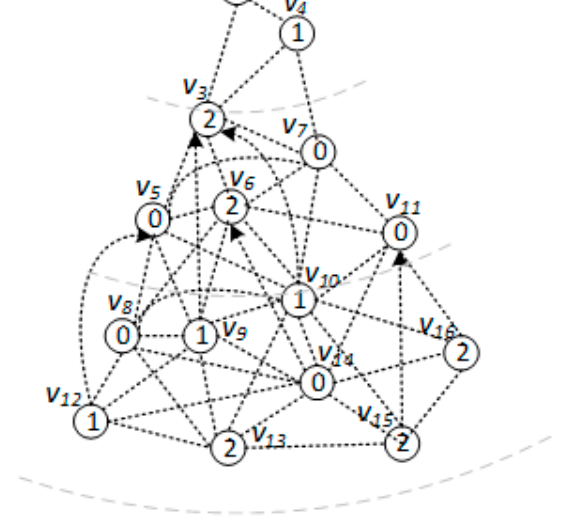
Figure 12. Original physical link.